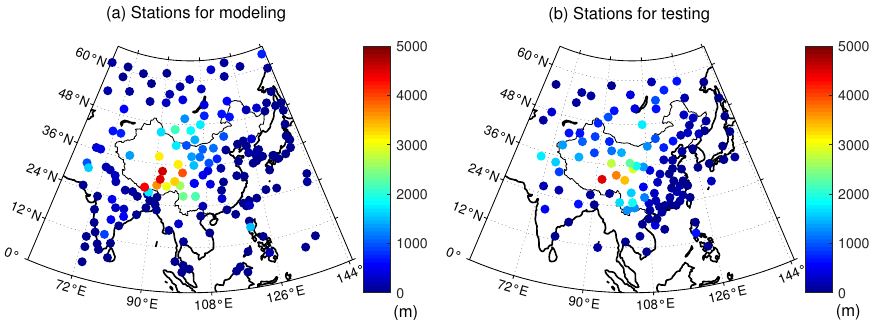
Figure 3. Distribution of the radiosonde stations for modeling ( a ) and testing ( b ).